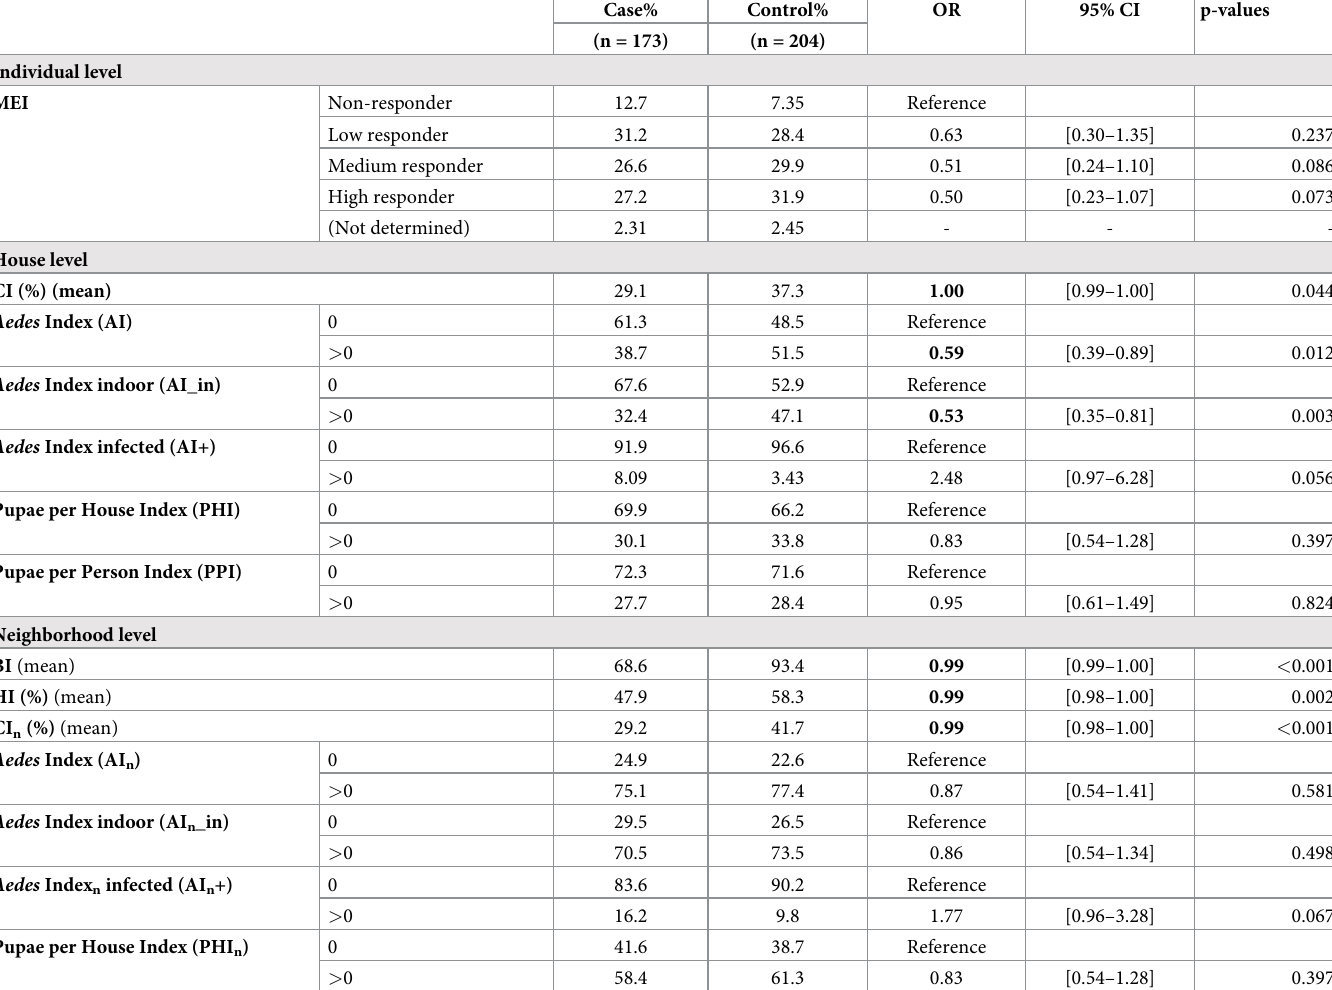
Table 2. Immunological and entomological indices and their associations with dengue fever cases in northeastern Thailand, June 2016 and June 2019. Odds ratios (OR) obtained by logistic univariable regression, and confidence intervals (95% CI) by Wald’s statistics. Odds ratios in bold are significant (p <